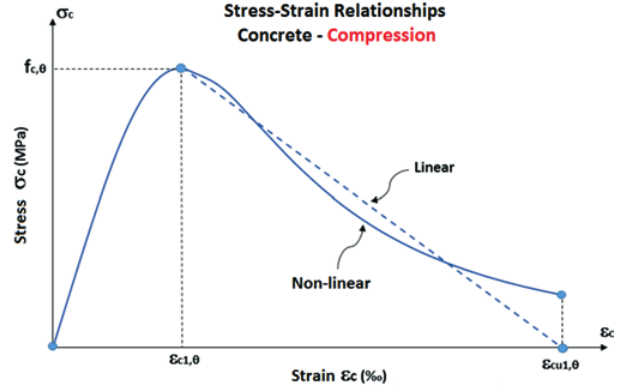
Figure 3 Stress-strain relationships of concrete under